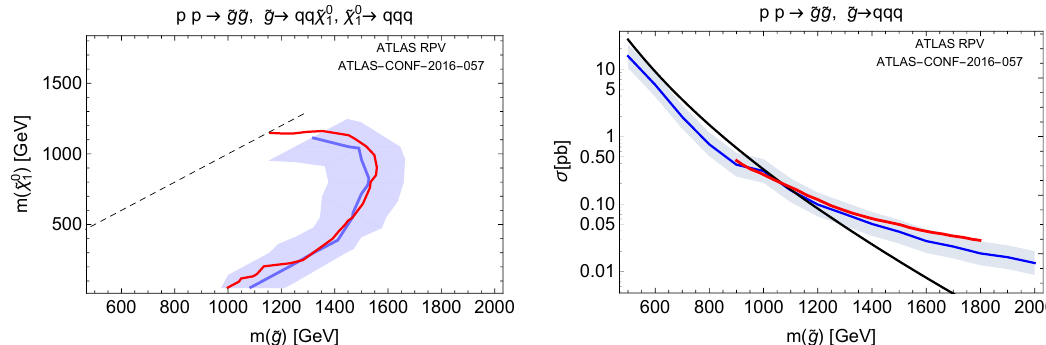
Figure 11 . Limits on supersymmetric simpli(cid:12)ed models from our recasted search of [33] (blue lines) with 50% error on the number of events in the signal regions (blue shaded regions), compared to the experimental results (red lines). On the right-hand plot, the expect gluino pair production cross section is shown in black.